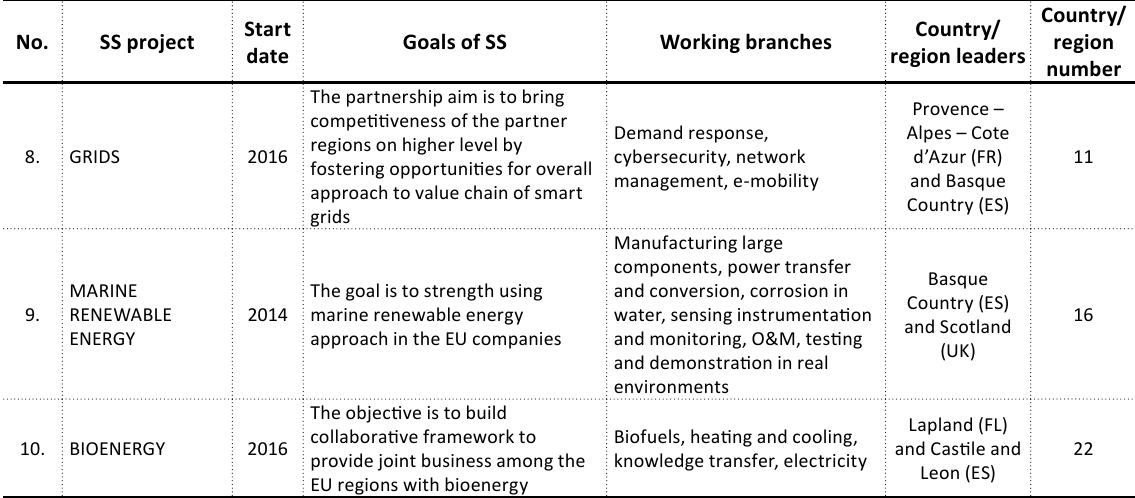
Table A1 (cont.). Examples of SS projects in the EU